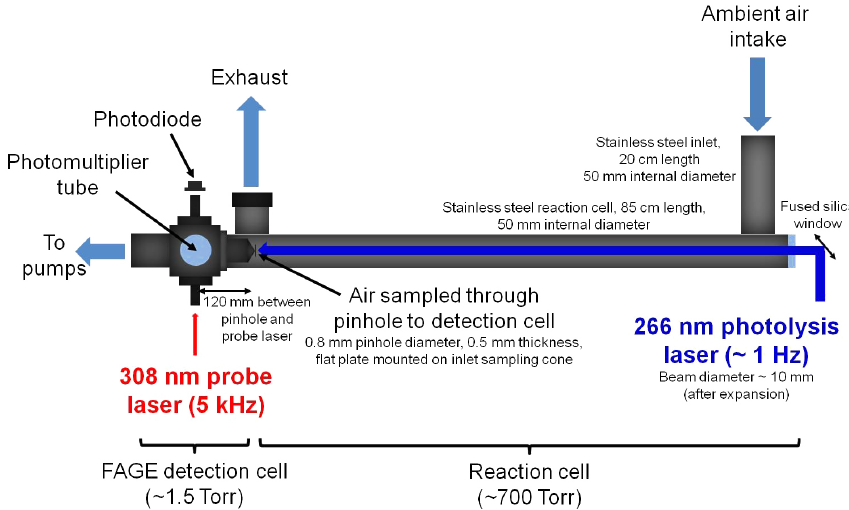
Figure 1. Schematic of the laser flash photolysis laser-induced fluorescence OH reactivity instrument for experiments and field measurements in which the FAGE detection cell was situated at the end of the reaction cell and sampled from the centre of the photolysed volume, leading to OH decays described by a single exponential. All laboratory and field measurements shown in this work were obtained with the instrument configuration as shown here. See text for further